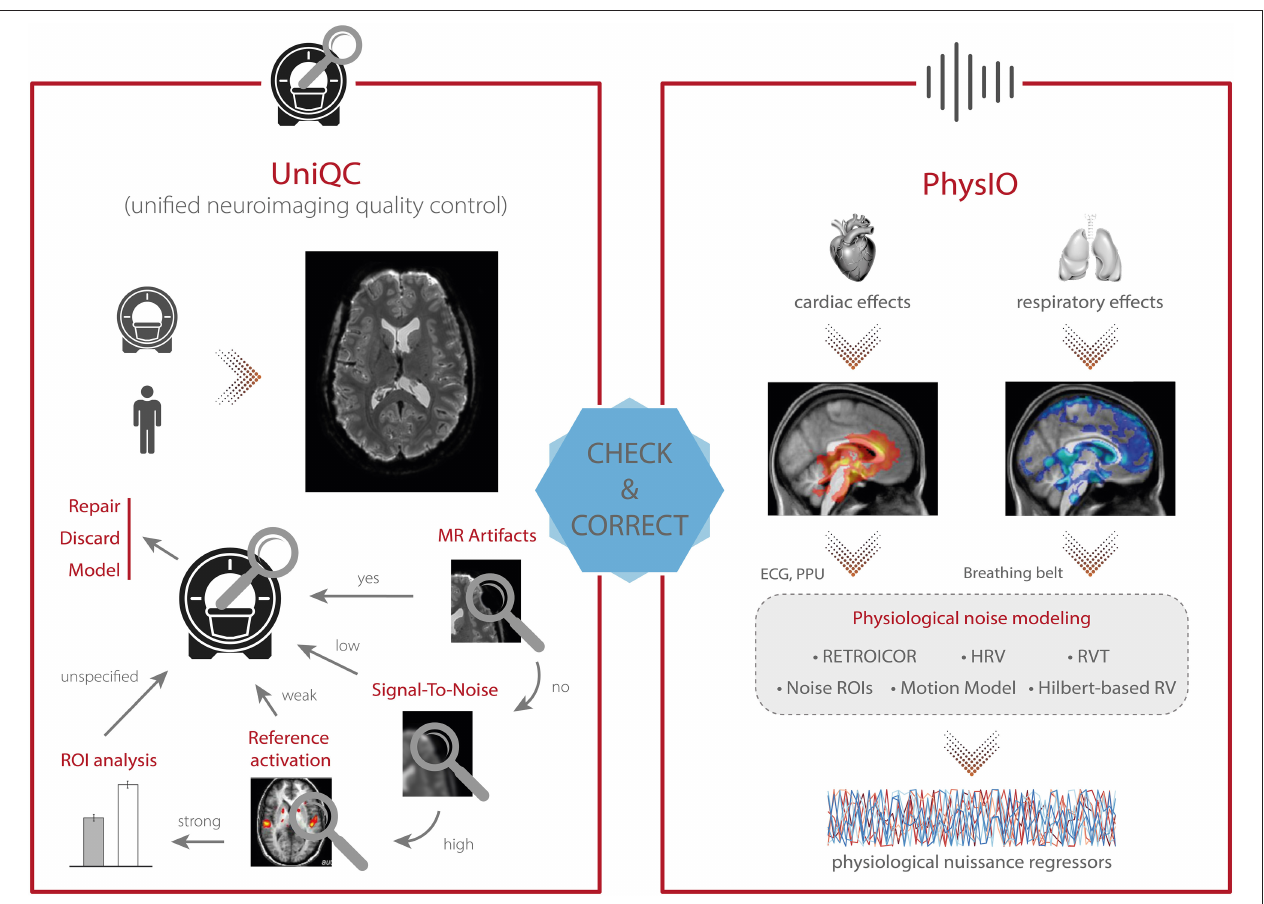
FIGURE 4 | TAPAS components that aim to monitor data quality and correct for physiological confounds. (Left) In addition to supporting the development and optimization of MR acquisition sequences (see Figure 3 ), UniQC also facilitates monitoring of data quality during data acquisition in order to quickly identify potential problems in the acquisition processes which might relate to malfunctions or alterations in the scanner hardware, as well as to artifacts related to the participant (e.g., motion, physiology). (Right) PhysIO implements model-based physiological noise correction based on peripheral recordings of cardiac [e.g., electrocardiogram (ECG), photoplethysmographic unit (PPU)] and respiratory (e.g., breathing belt) cycle. The toolbox uses RETROICOR as well as modeling of the impact of heart rate variability (HRV) and respiratory volume per time (RVT) on the BOLD signal (e.g., using Hilbert-based respiratory volume) to derive physiological nuisance regressors that can be utilized in subsequent statistical analyses to account for physiological confounds in fMRI